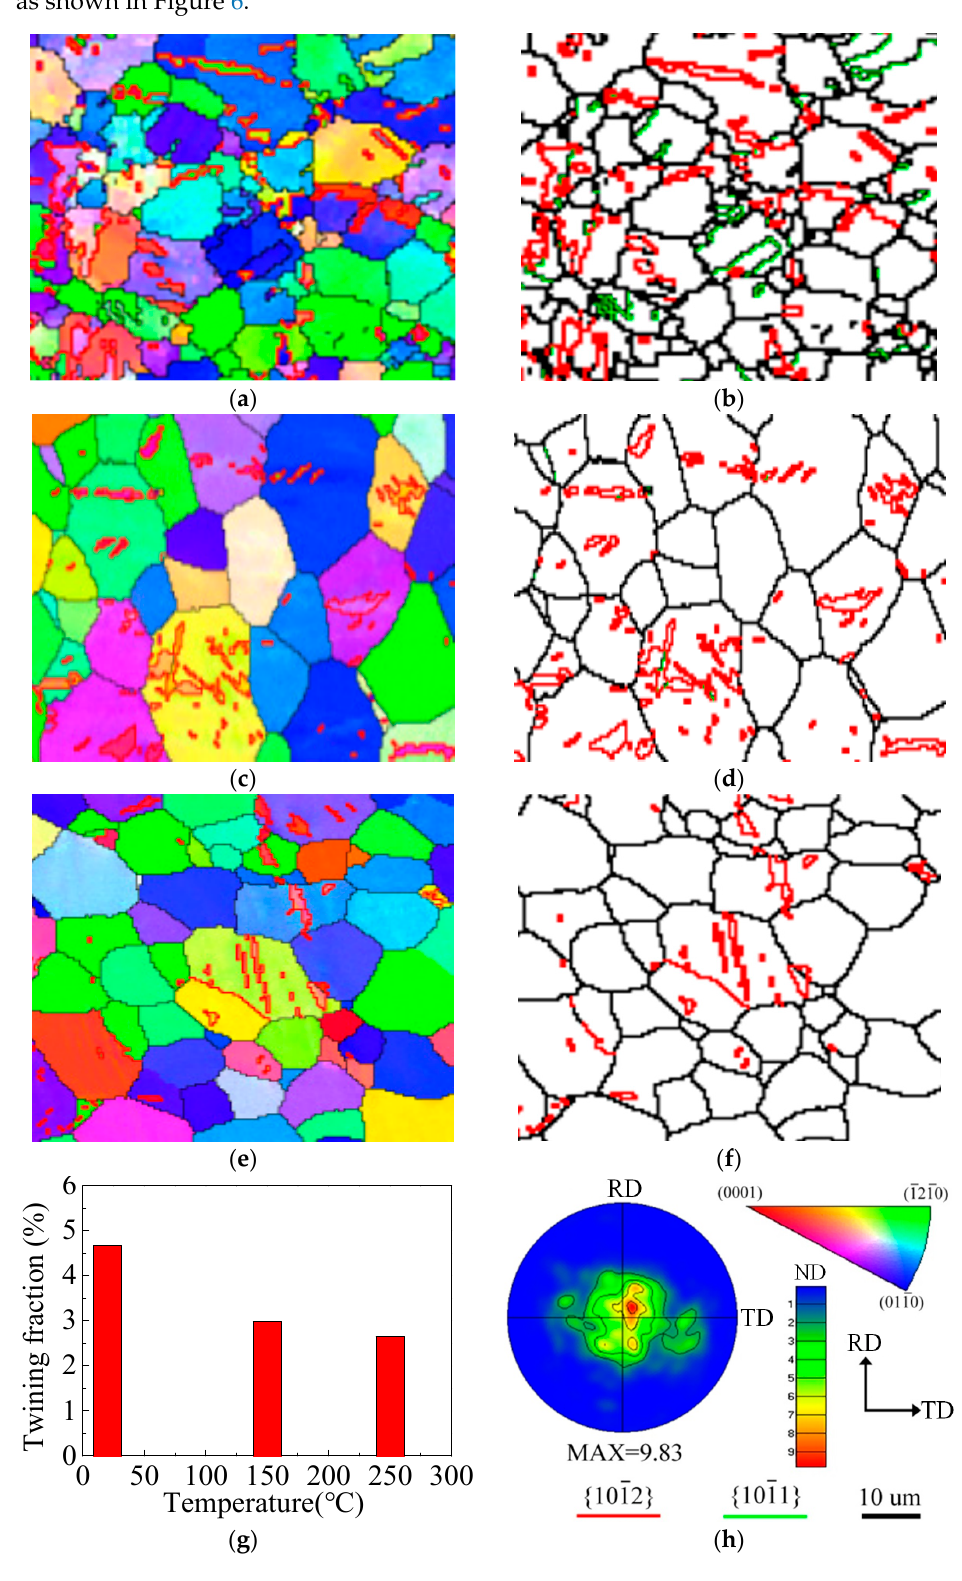
Figure 4. IPF maps, PF maps, BM maps and TVF of impacted wrought AZ31 ‐ TD alloy: ( a ) IPF at 20 °C, ( b ) BM at 20 °C, ( c ) IPF at 150 °C, ( d ) BM at 150 °C, ( e ) IPF at 250 °C, ( f ) BM at 250 °C, ( g ) twinning fraction under different temperature condition, ( h ) PF at 20 °C.